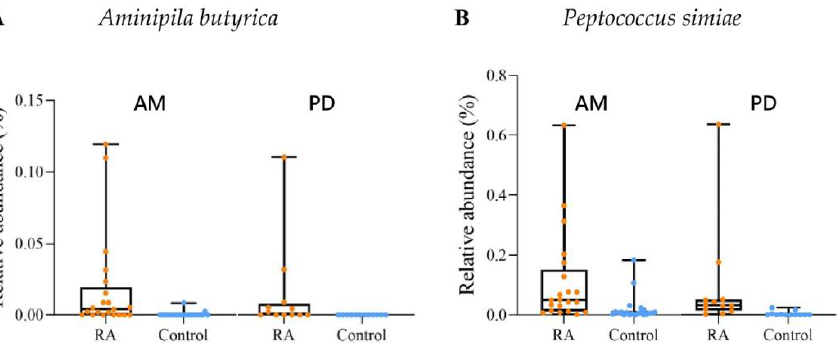
Figure 4. Relative abundances of ( A ) A. butyrica and ( B ) P. simiae displaying positive correlations to the ACPA levels in both of groups AM and PD. RA, the RA patients in this study; Control, the controls in this study. The data are expressed as median (25th, 75th